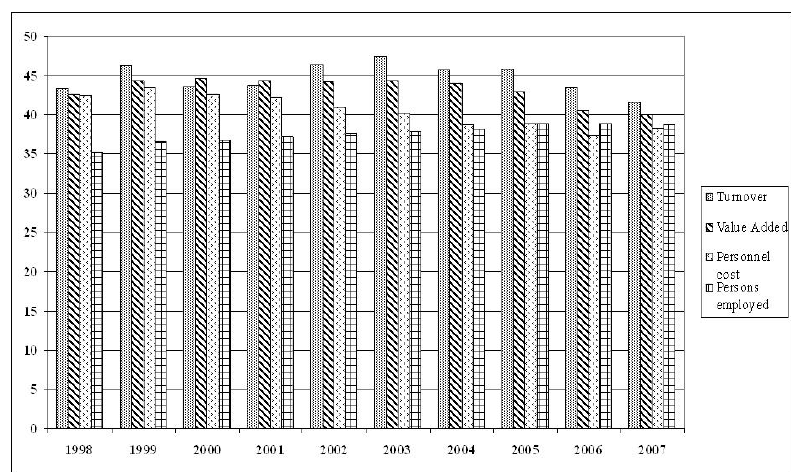
use rank correlation, Fligner-Policello test and representativity indicators and do not show statistical difference. The good panel representativity may be shown also by means of the coverage ratio (Figure 2) calculated on the basis of the subset of firms existing in all years (balanced panel) 4 .